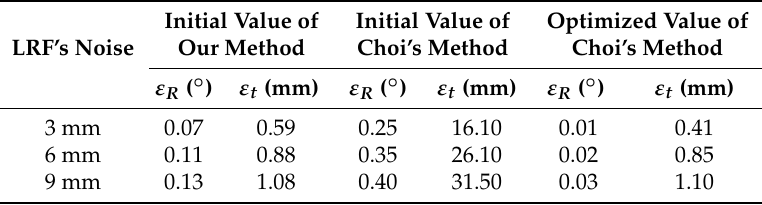
Table 1. The rotation error and translation error of the LRFs’ extrinsic parameters calibrated by our method and Choi’s